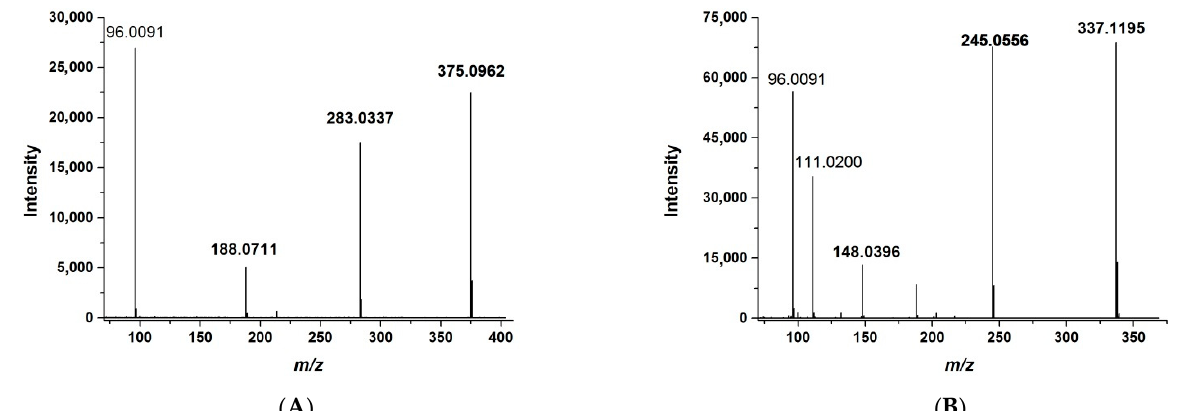
Figure 1. The high ‐ resolution mass spectrum of ST ‐ 246 ( A ) and the IS ( B ) registered by the PRM method. For fragment ions selected for the quantification (boldfaced), masses are pointed out. Several fragment ion m / z values were selected for the detection and quantification: